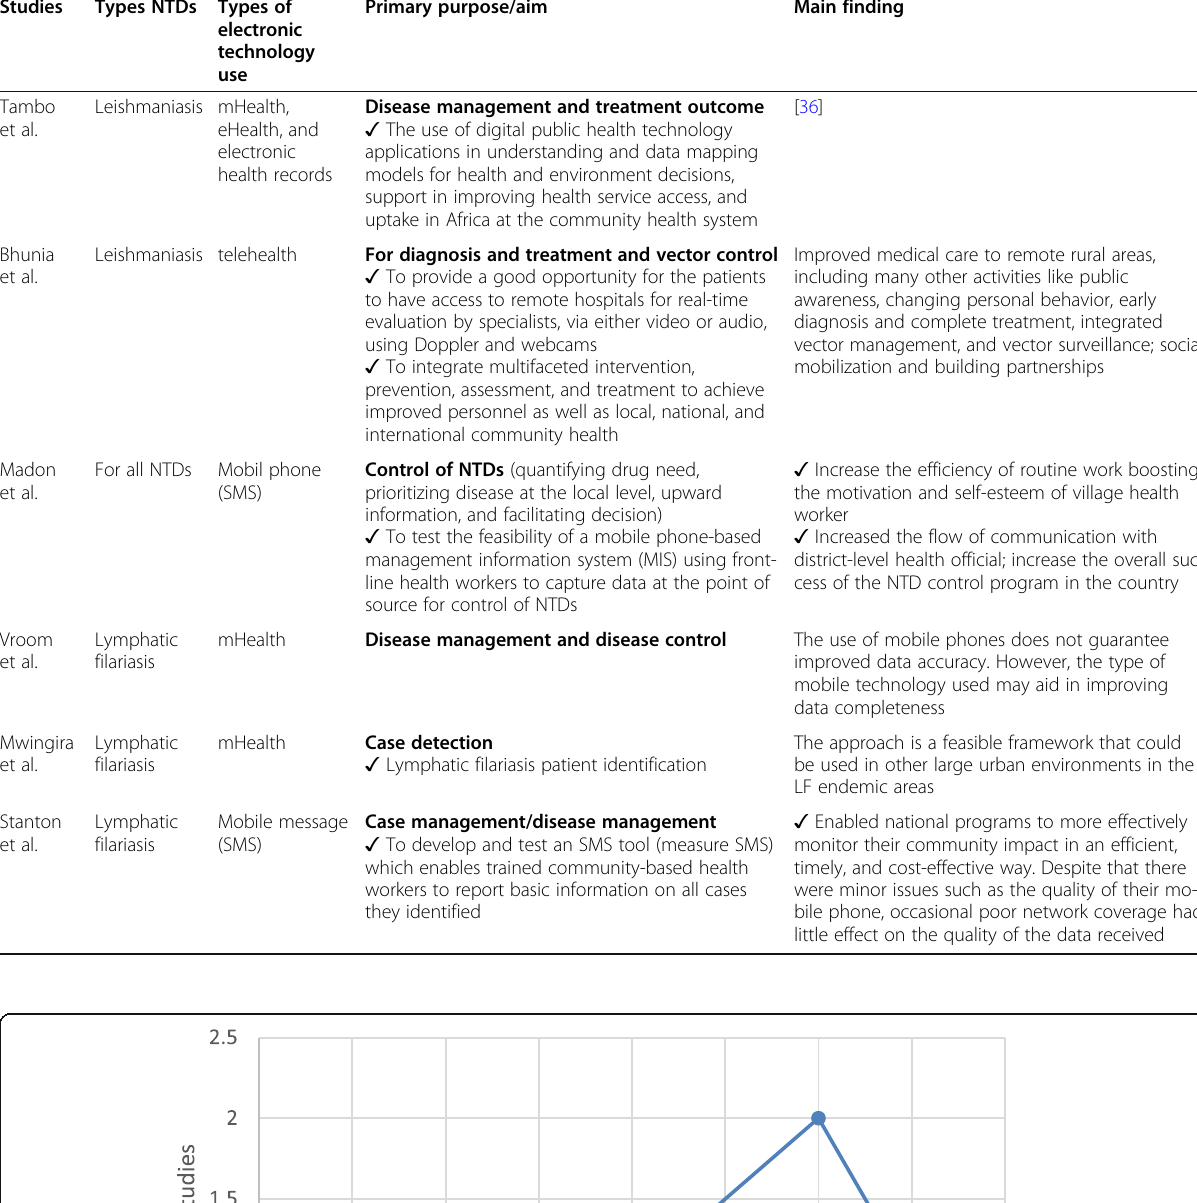
Table 2 Summary of extracted data on the purpose of electronic technology use and their main outcome Studies